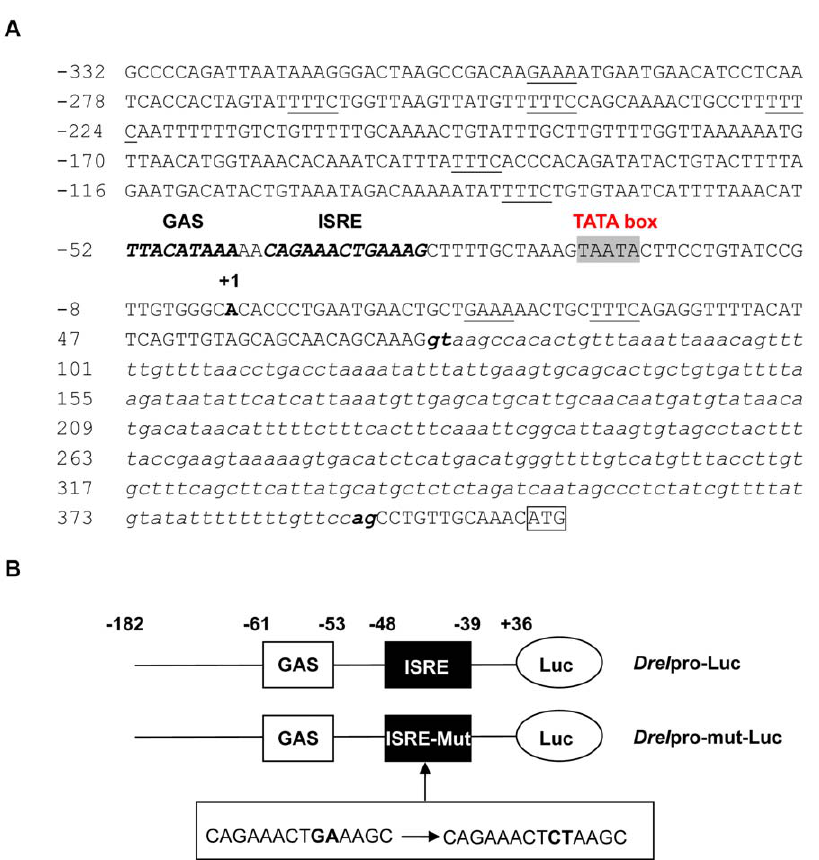
Figure 3. Analysis of the 5 9 flanking regulatory sequence of DreI . (A) The 5 9 flanking region of DreI was mined from NCBI public database. The putative transcription start site was in bold and the start code of the DreI transcript was boxed. The intron in 5 9 UTR of DreI is indicated with lower case italics and the conserved flanking GT/AG dinucleotides are shown in bold. The putative ISRE motif and GAS site were in italic type. The TATA box is shaded in grey and Eight GAAA/TTTC motifs are underlined. (B) The schematic of 5 9 flanking region of DreI . To analyze DreI promoter activity, the region containing ISRE and GAS motifs was cloned in front of luciferase reporter gene. To construct the ISRE mutant promoter, the purine G and A in 2 59 and 2 58 were mutated to pyrimidine C and T, respectively.